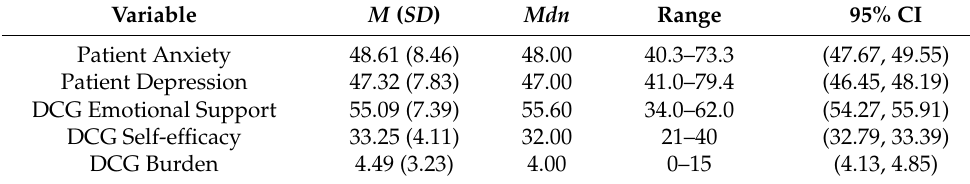
Table 2. Descriptive summary of study variables ( N =